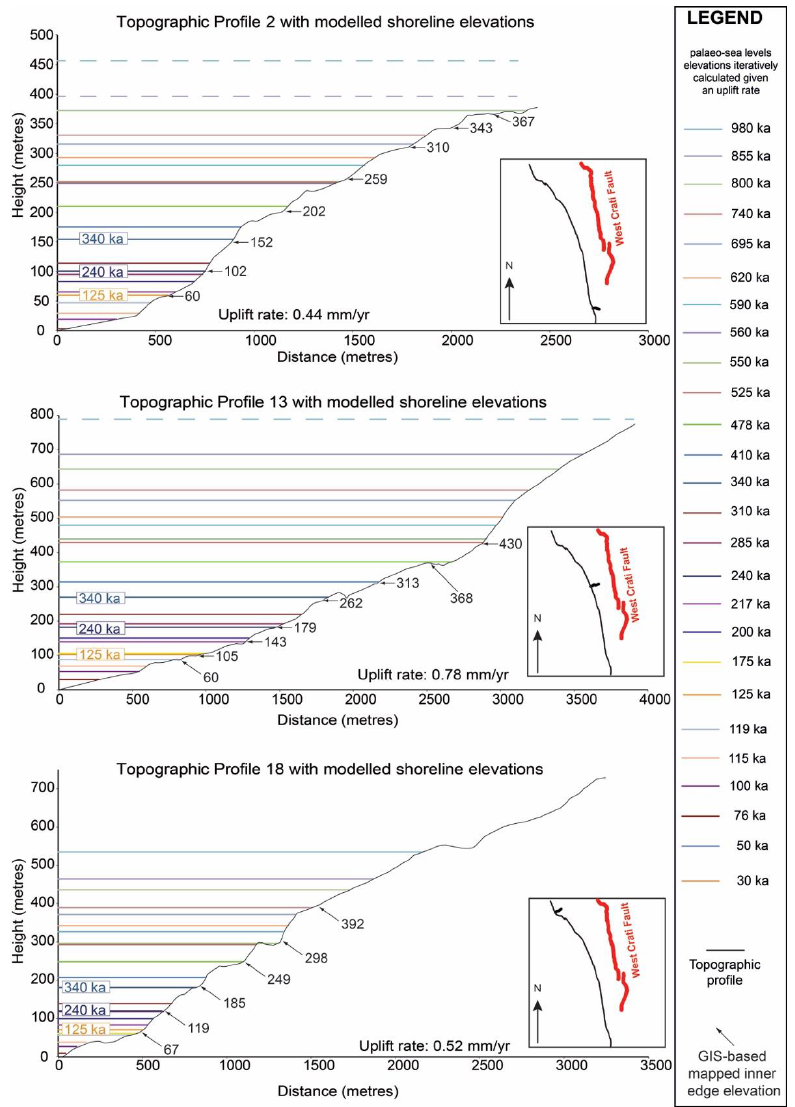
Figure 4. Topographic profiles derived by using 10 m high-resolution DEMs (Tarquini et al., 2012) from fault tips area and the centre of the fault showing modelled palaeoshoreline elevations. Sea-level highstands, identifying and predicting palaeoshoreline elevations, are represented by coloured lines that are calculated by iterating values of uplift rate to find the best match with the mapped (numbered arrows) palaeoshorelines. All topographic profiles are shown in Figures 2 and S5–S10. Inner edge elevations with refined ages are also shown in Table